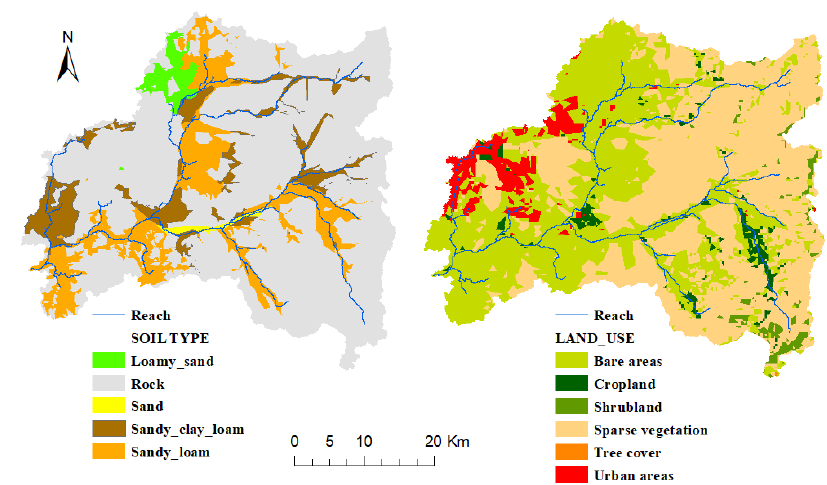
Figure 6. Land use/cover and soil type distribution for the Makkah watershed.